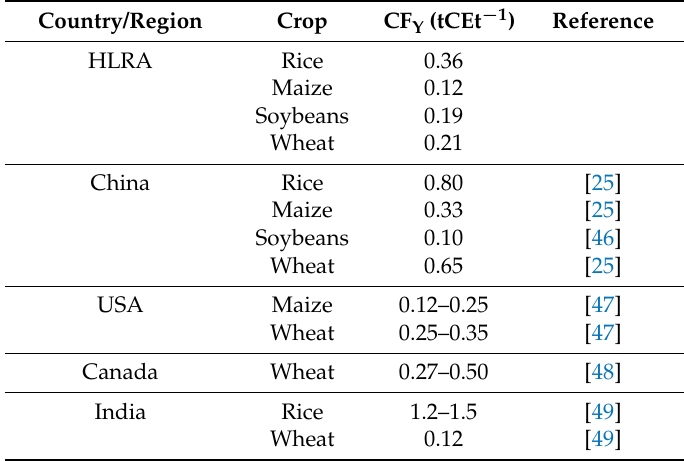
Table 7. Comparison of international carbon intensity in crop